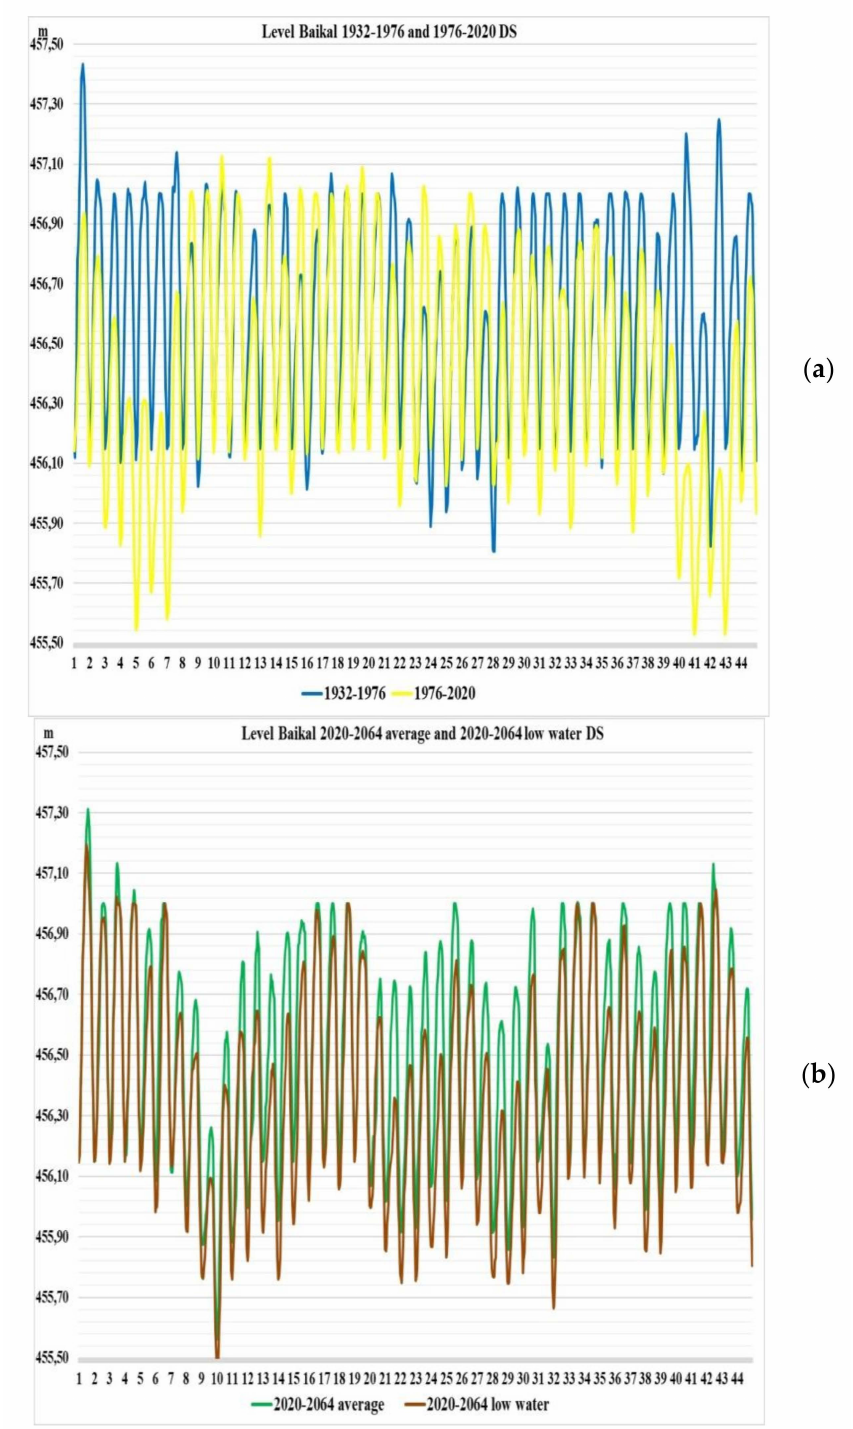
Figure 8. Water level of the Baikal obtained as a result of WRC by DS for series 1932–1976 and 1976–2020 ( a ) for series 2020–2064 average and 2020-2064 low water ( b